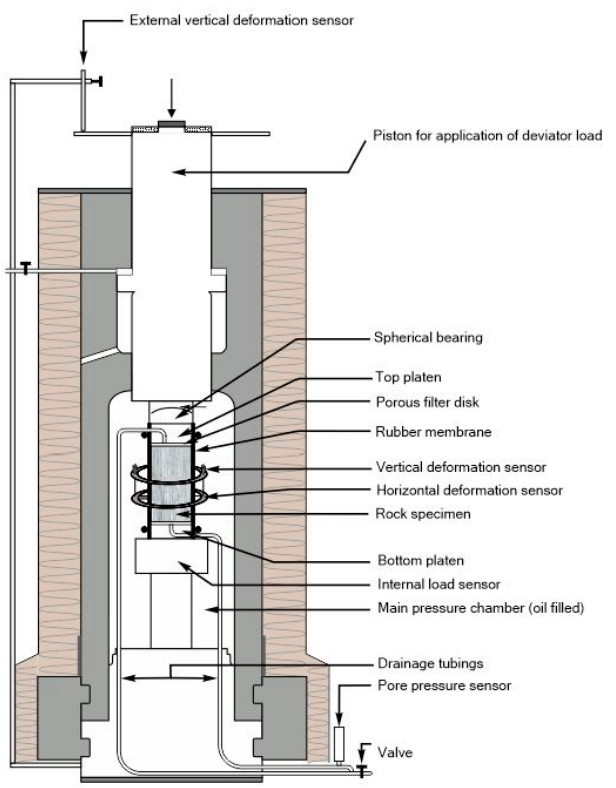
Figure 2. Schematics of the interior of the triaxial cell used in the current study.